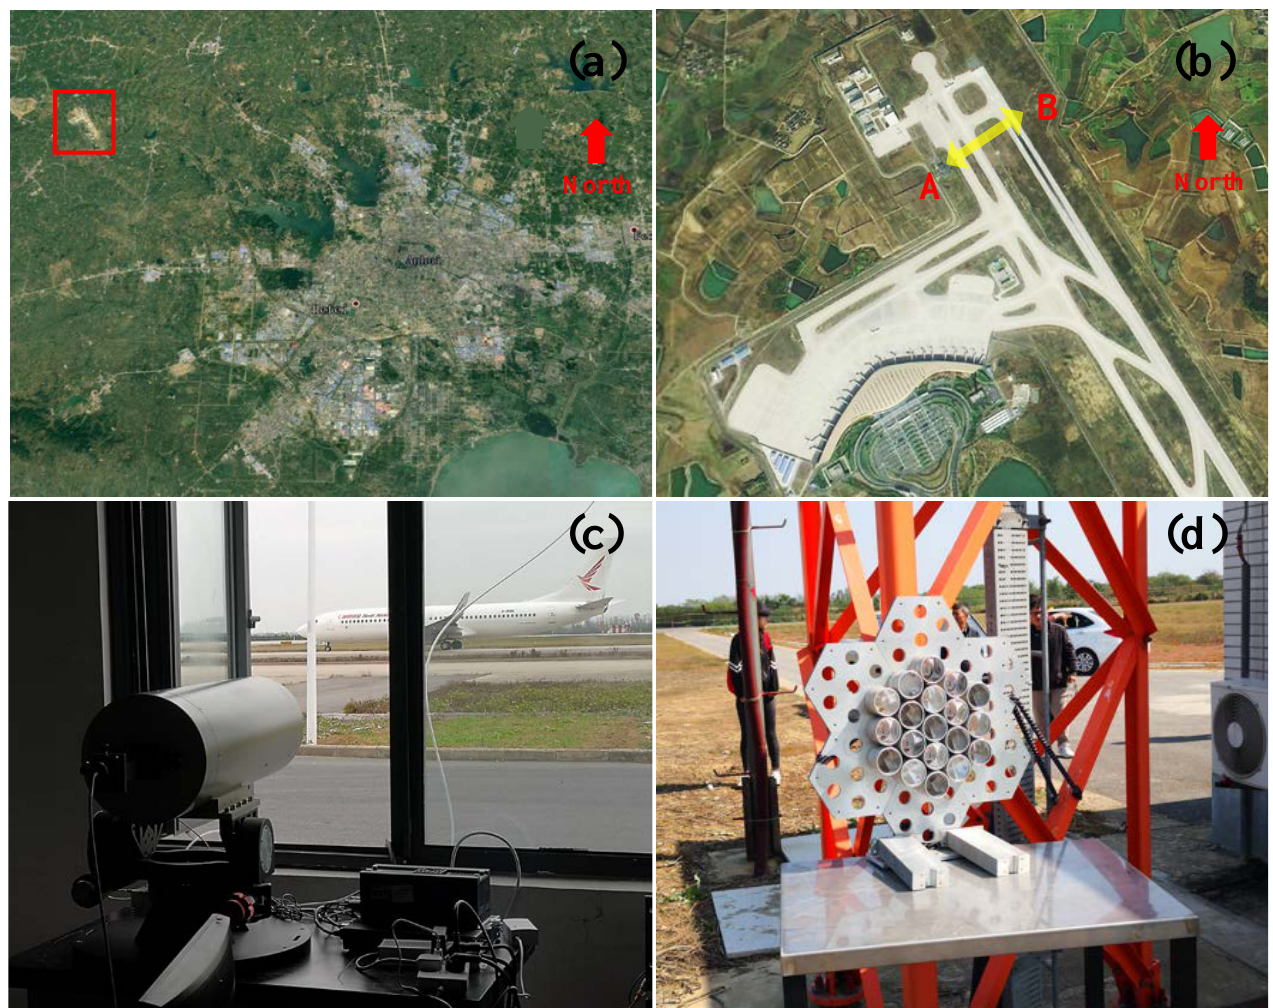
Figure 2. ( a ) The location of Hefei Xinqiao International Airport. ( b ) The measurement site. ( c ) Photograph of the integrated transmitter/receiver telescope. ( d ) Photograph of the array of quartz corner cube retroreflectors.